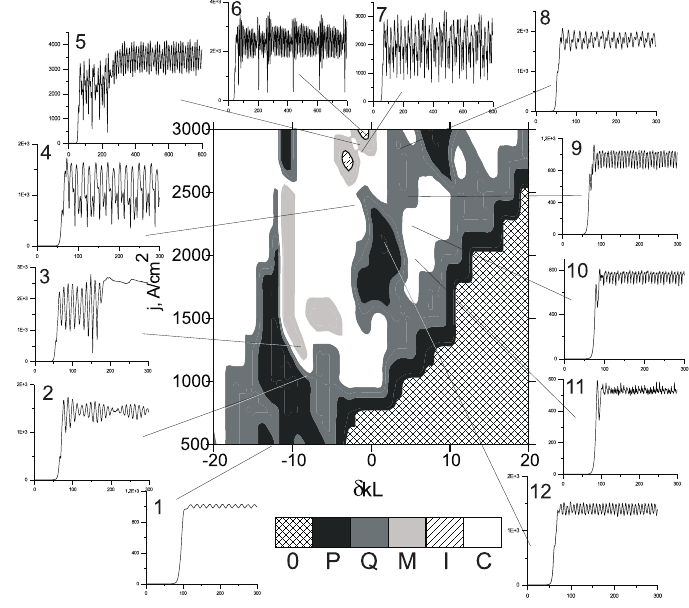
Figure 4. Two-parametric maps of chaotic lasing for transmitted wave. 0 depicts a domain under beam current threshold. P, Q, C correspond to periodic regimes, quasiperiodicity and chaos, respectively. M describes domains with transitions between large-scale and small-scale amplitudes. I stands for intermittency. On edges of each chart the most typical dependencies of fields intensities on time (in ns) are presented. 0 depicts a domain under generation threshold where generation of electromagnetic radiation is not realized. After overcoming this threshold by parameters j and δ the radiation gain of generating mode becomes equal to absorption and generation begins and develops actively. All main dependencies of different threshold points were investigated analytically in [2] and numerically in [4,